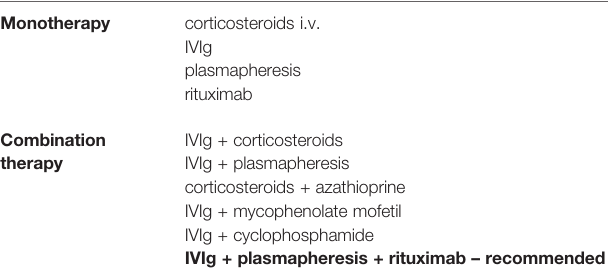
TABLE 2 | The most commonly used drugs in monotherapy and combination therapy for anit-IgLON5 disease.